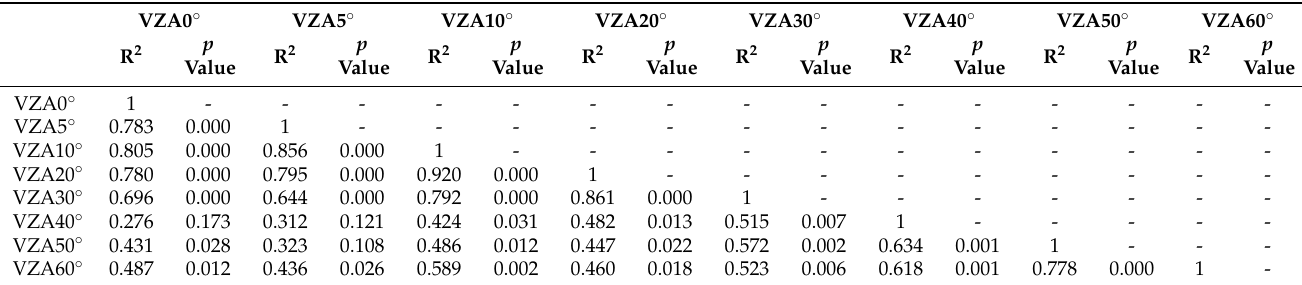
Table 3. Coefficient of determination (R 2 ) between the MCARI/OSAVI values at different VZAs.